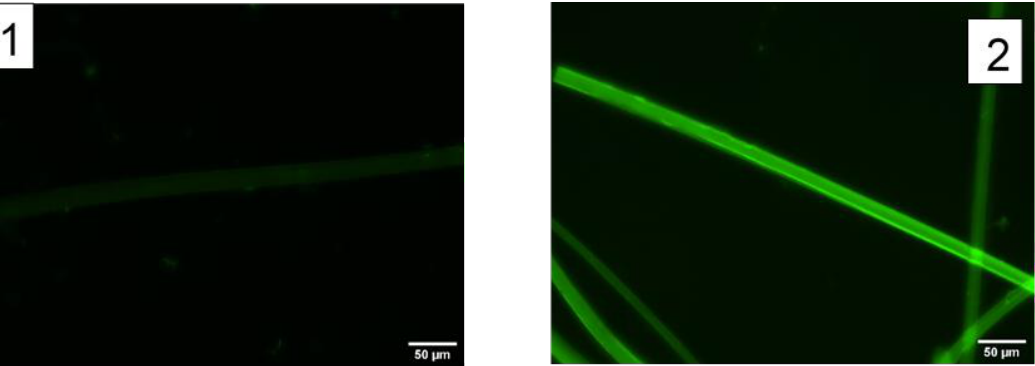
Figure 5. Illustrative fluorescence micrographs of ( 1 ) a control fiber incubated with fluorescent-RGD peptide in the absence of the EDC/NHS crosslinkers, and ( 2 ) a fiber incubated with fluorescent-RGD peptide in a solution containing the EDC/NHS crosslinkers.